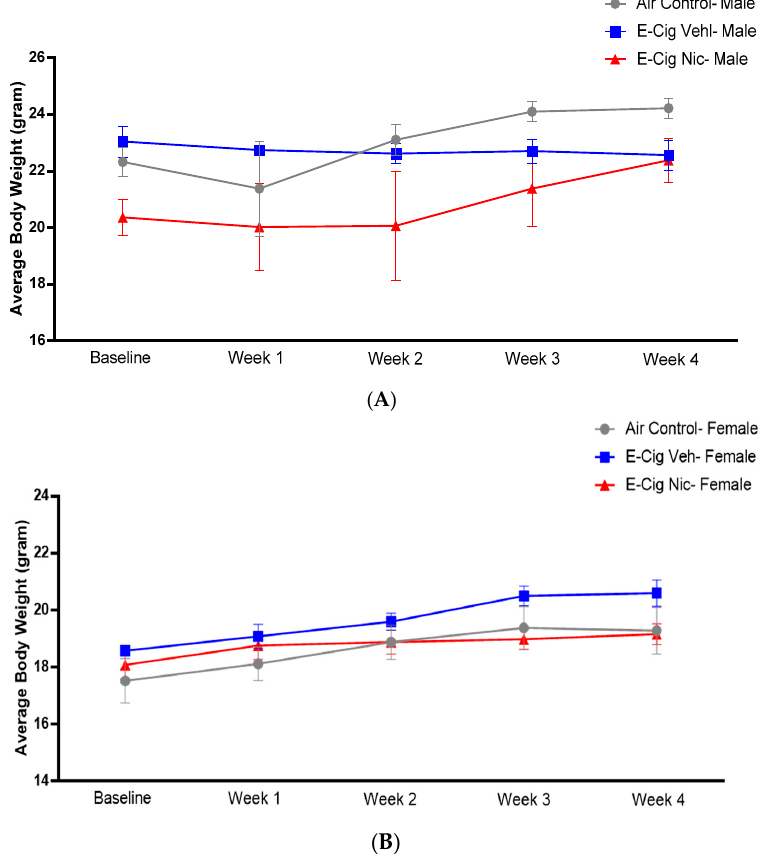
Figure 2. Average body weight of ( A ) male and ( B ) female mice of the three groups (Air control, E-Cig Veh, E-Cig Nic) during the study (four weeks). One-way analysis of variance (ANOVA) did not show any significant changes between the three groups in female and male mice. Data are presented as mean ± SEM (n = 5/group). E-Cig; electronic cigarettes, E-Cig Veh; electronic cigarette vehicle, E- Cig Nic; electronic cigarette nicotine.